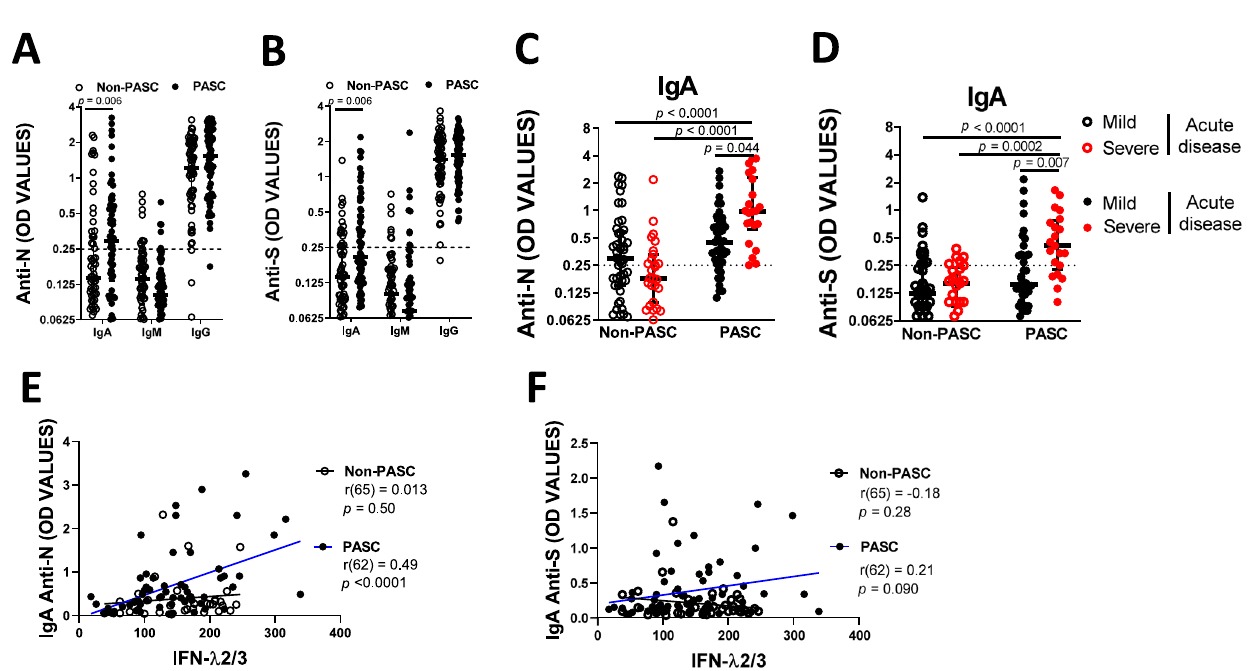
Fig. 7 | Type III interferon and IgA signatures on Post COVID-19 condition. Quanti fi cationoftheanti-N( A )andanti-S( B )IgA,IgMandIgGresponseafterSARS- CoV-2 infection divided byindividuals thatdeveloped( n =62) or notPASC( n =65) sixmonths afteracute disease. Quanti fi cation of anti-N ( C ) and anti-S IgA ( D ) atsix months after SARS-CoV-2 infection on non-PASC ( n =65) and PASC ( n =62)